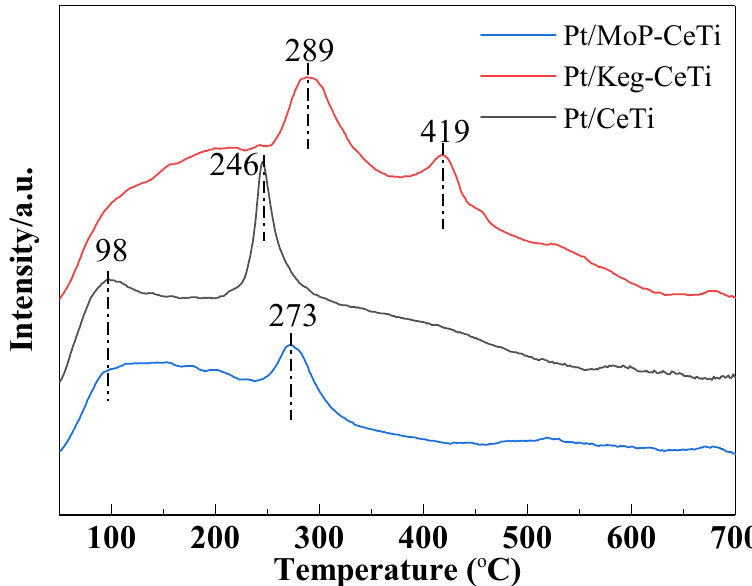
Figure 8. NH 3 -TPD profiles of the Pt/CeTi, Pt/Keg-CeTi, and Pt/MoP-CeTi catalysts.